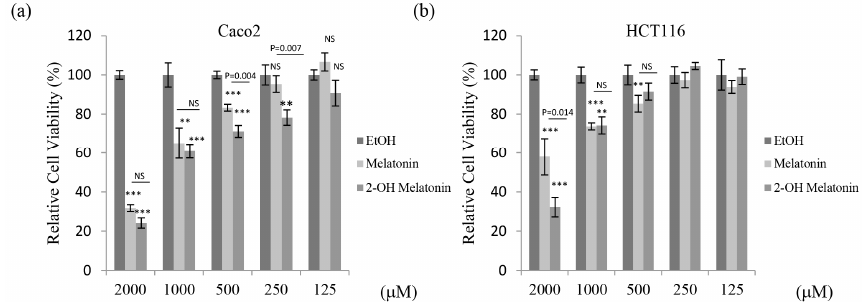
Figure 1. Cont. Figure 1.